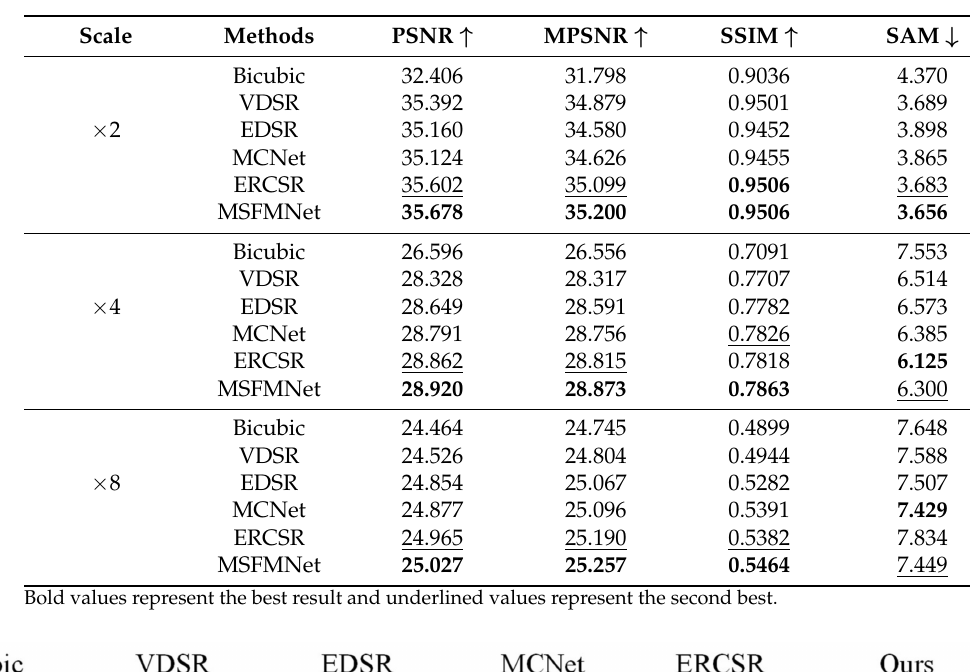
Table 2. Quantitative evaluation on the Pavia dataset of state-of-the-art hyperspectral image sr algorithms: average psnr/mpsnr/ssim/sam for scale factors 2, 4, and 8.